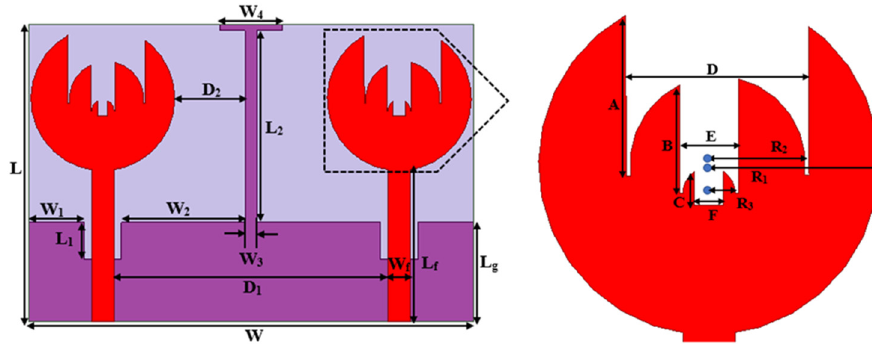
Figure 1. Two-element MIMO antenna design and parameters. Table 1. Design parameters of the two-element MIMO antenna.